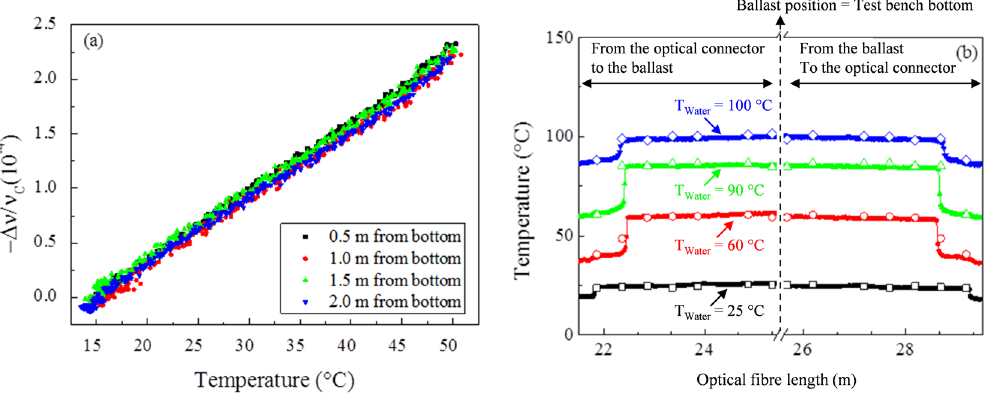
Figure 5. Distributed temperatures in operating and accidental conditions. ( a ) Temperature calibration curves during water heating (15–50 °C) around four different thermocouple positions along the test bench height. ( b ) Temperature evolution along the fibre length inside the test bench (sensor probe) at four different situations during the experiment: operating condition with water at ~25 °C (black solid dots), operating condition with water at ~60 °C (red solid dots), accidental condition with water at ~90 °C and (green solid dots), accidental condition with water at ~100 °C, presence of steam inside the chamber and boiling water (blue solid dots). The open dots in each curve represent the temperature values detected with the thermocouples placed along the test bench